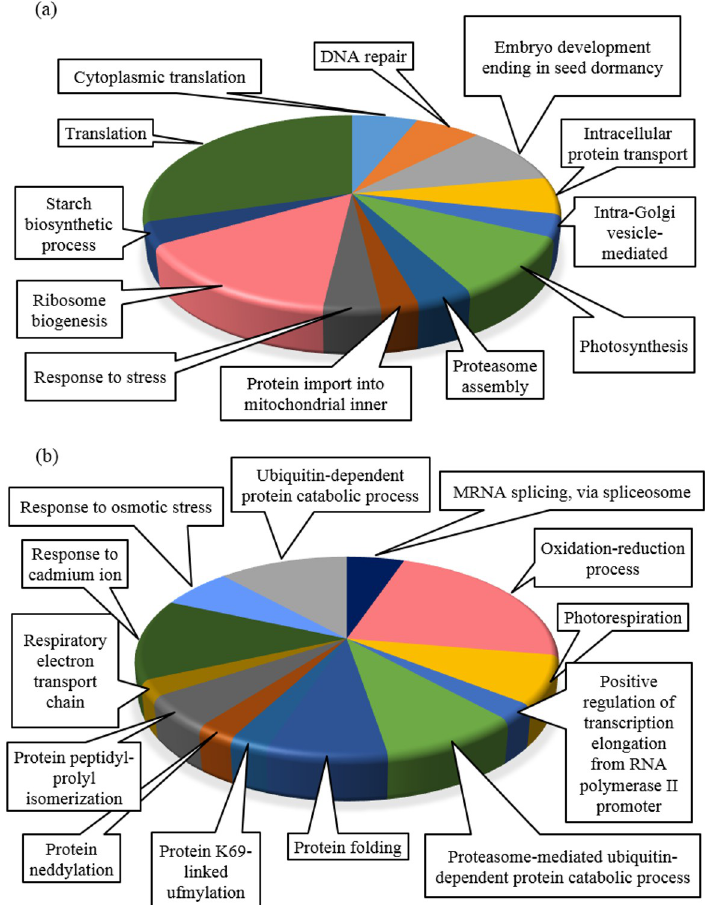
Fig 6. GO analysis of hub genes ( P-value � 0.05). (a) Biotic hub genes. (b) Hormonal hub genes.